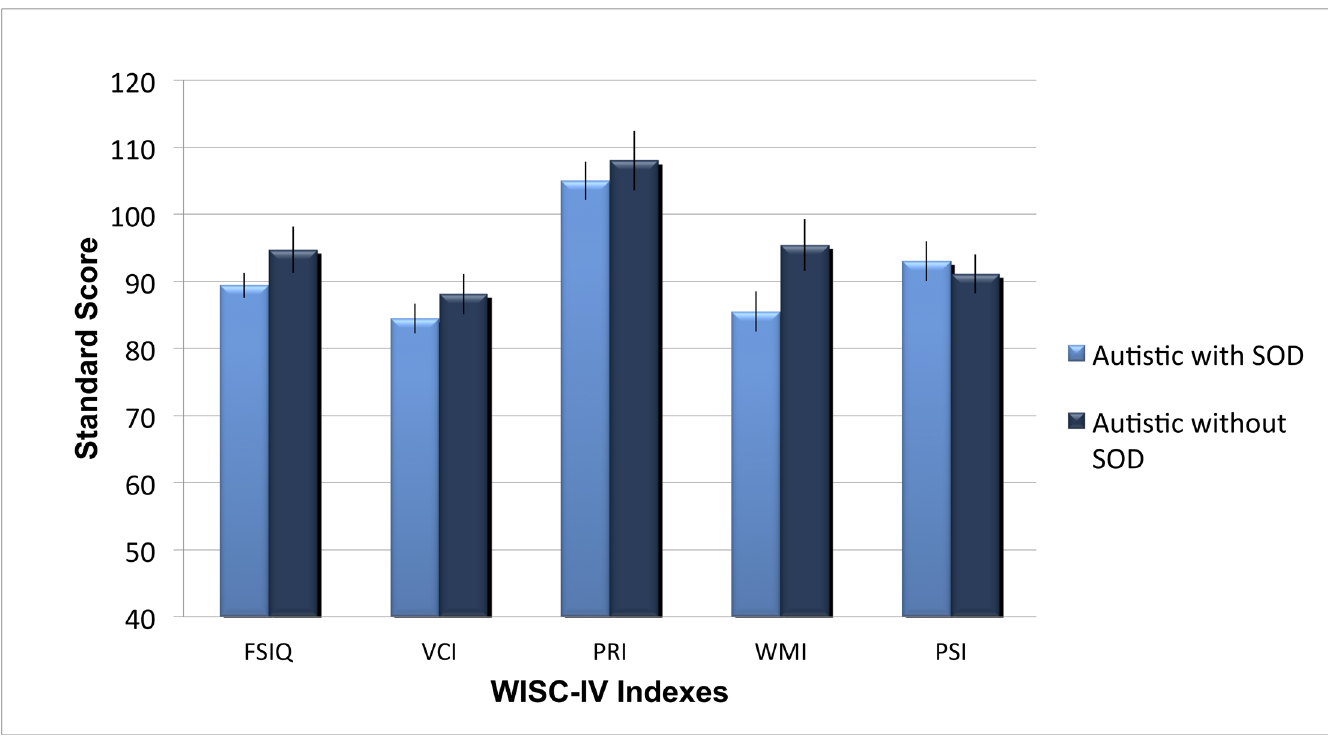
Fig 2. WISC-IV profile of autistic children with and without speech onset delay. Mean standard score on WISC-IV comparing autistic with and without speech onset delay (SOD). FSIQ: Full Scale IQ, VCI: Verbal Comprehension Index, Perceptual Reasoning Index, WMI: Working Memory Index, PSI: Processing Speed Index. Error bars represent standard error from the